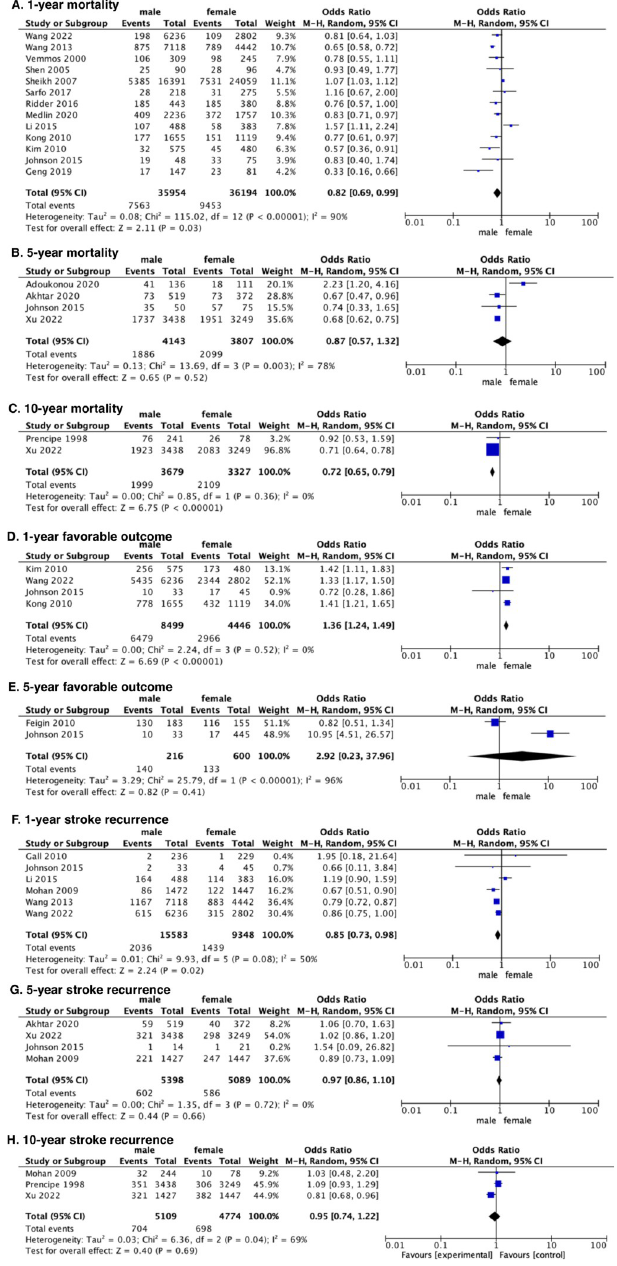
Fig 2. Forest plots showing primary outcomes between males and females. M-H Mantel-Haenszel statistic.